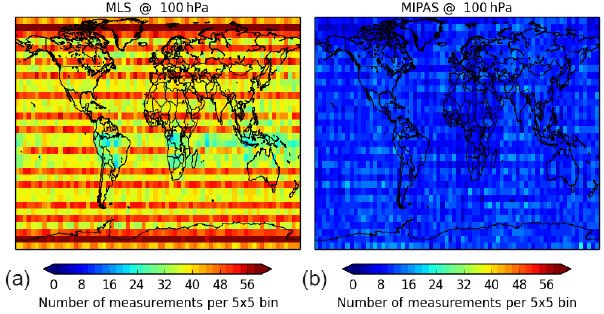
Figure 2. Number of measurements averaged within 5 ◦ × 5 ◦ bins at 100hPa in January 2012 in the MLS (left) and MIPAS (right) data